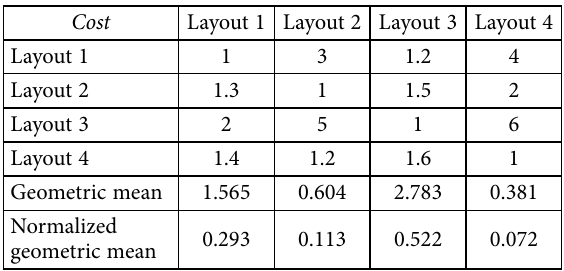
Table 4. The comparison matrix of the layouts for cost